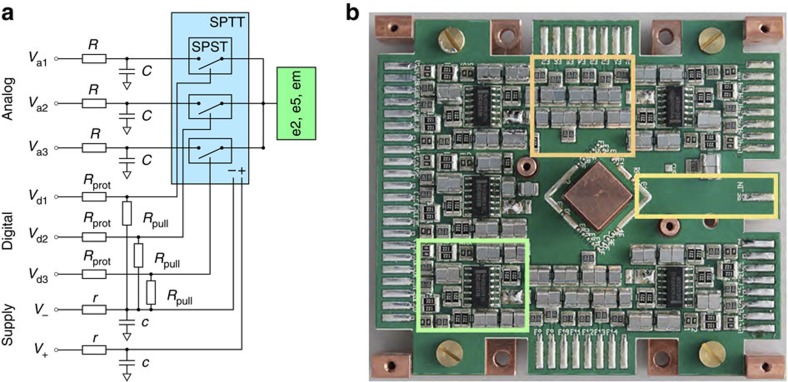
Cryogenic electronics.(a) Realization of a single-pole triple-throw (SPTT) switch for a switchable control electrode. r and c form low-pass filters for the supply lines of the CMOS switches (V+, V−), with a cutoff frequency of ≈14 kHz. R and C form low-pass filters for the input DC voltages (Va), with a cutoff frequency of ≈14 Hz. As usual in rf traps, the capacitors have the additional function of rf-grounding the control electrodes. Rprot and Rpull are over-current protection and pull-down resistors for the digital control lines of the single-pole single-throws (SPSTs). Va is passed on to the electrode by closing the SPST with a digital high/low level through the control line Vd. (b) Picture of the CEB. The circuitry relative to one of five switches is highlighted in green, a group of seven RC filters in orange and the position of the rf track (inside the printed circuit board) in yellow. The CEB is mounted on a copper structure for thermal contact to the cold plate.